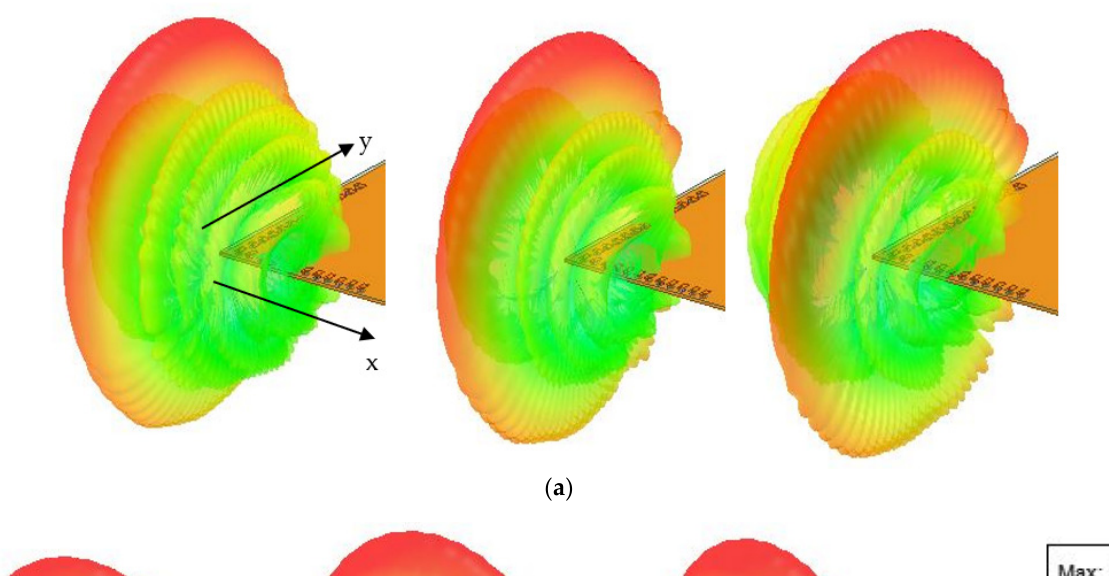
Figure 3. ( a ) Simulated array gains for various scanning angles in the elevation plane at 26.5 GHz. ( b ) Zoomed − in version of the gains for a smaller theta range.